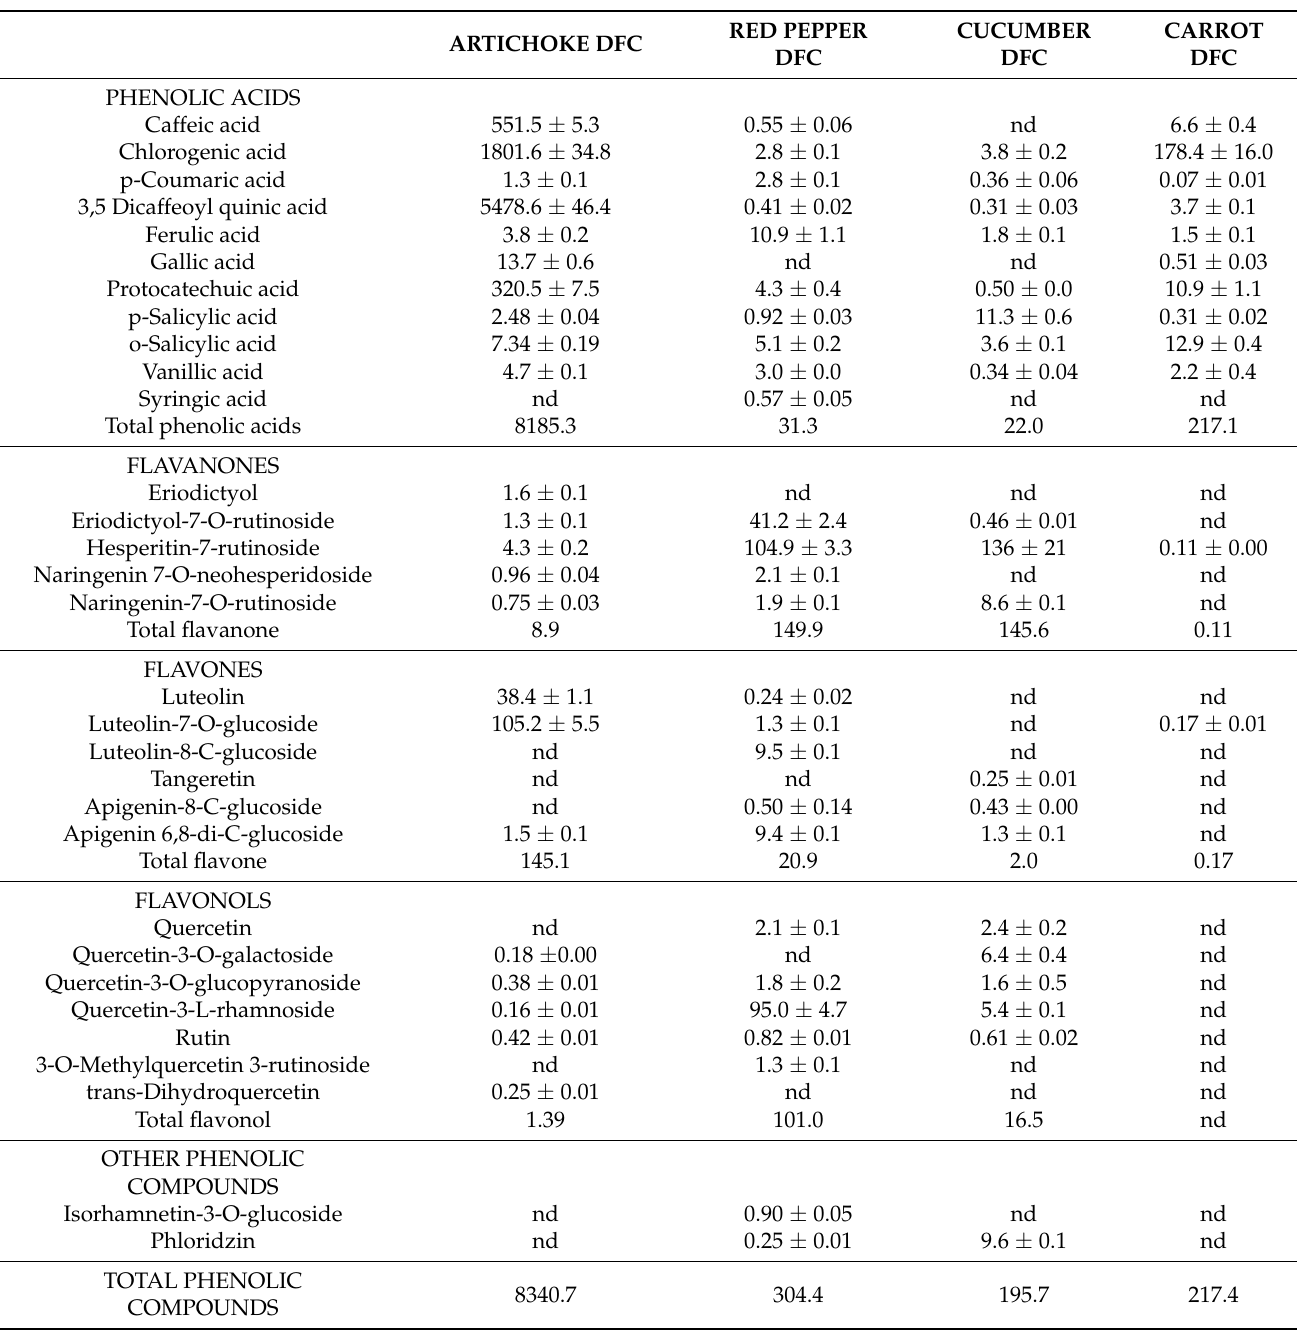
Table 3. Phenolic compounds profile (mg/kg) of vegetable dietary fibre concentrate